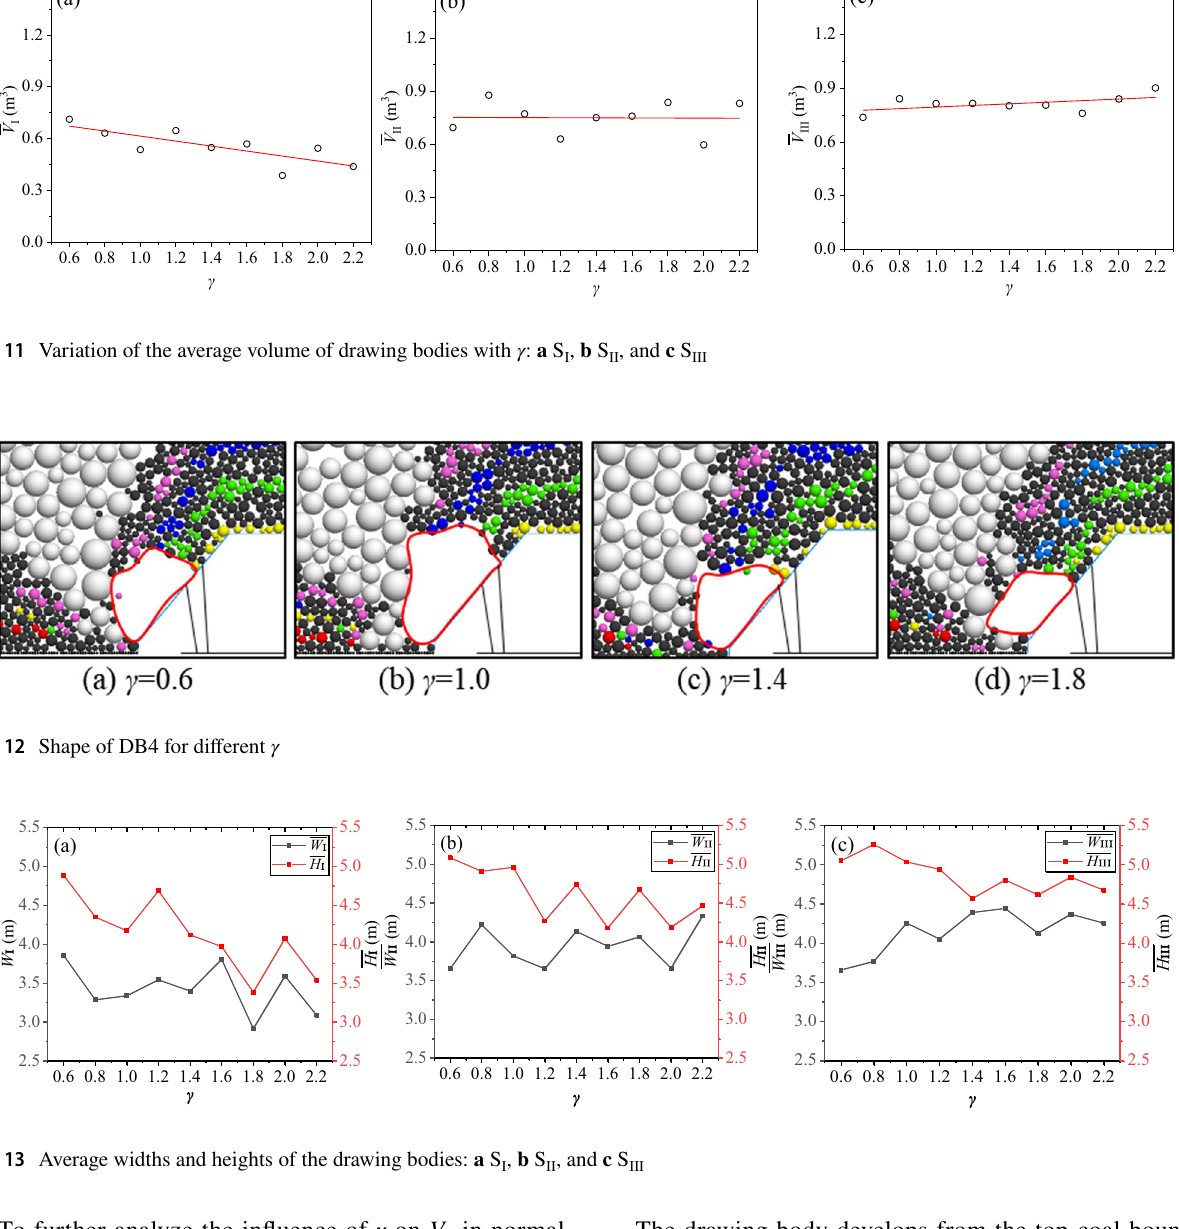
I , b S II , and c S